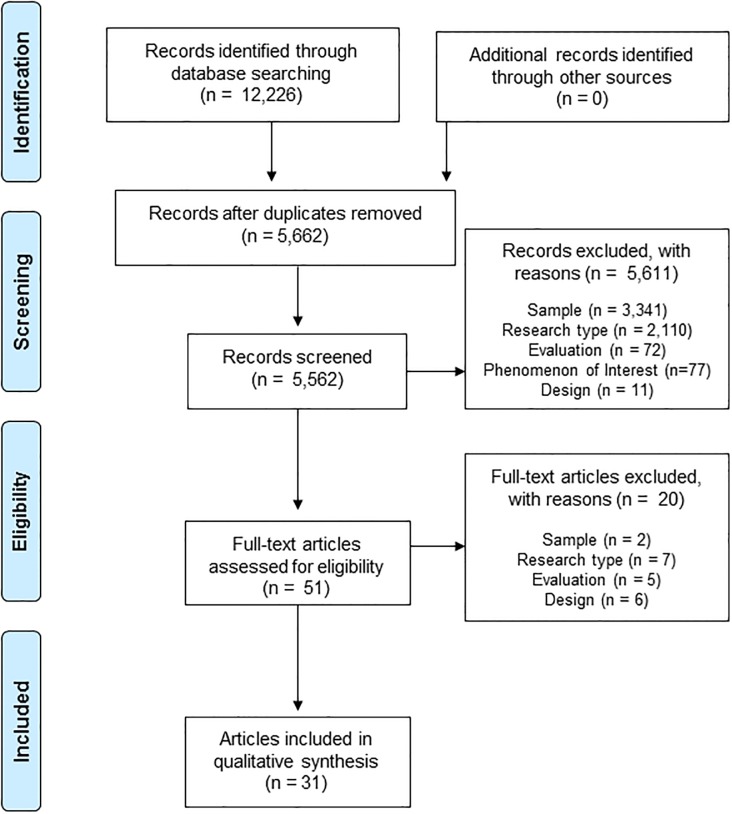
PRISMA flow diagram [72].